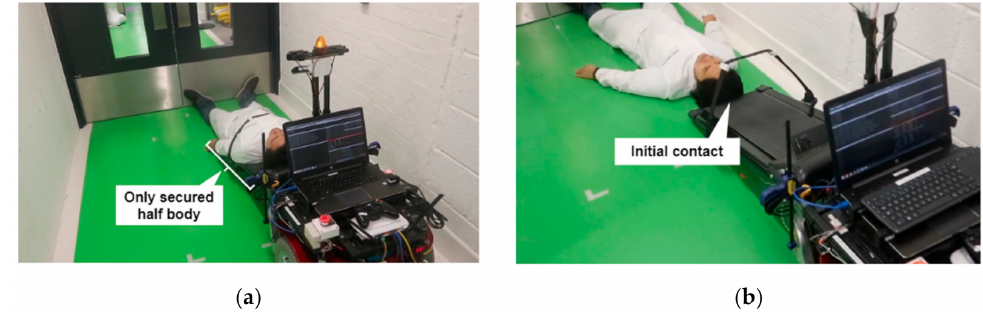
Figure 3. Two critical concerns of the ResQbot 1.0 design: ( a ) ResQbot 1.0 can only load and secure half of the casualty’s body (i.e., upper body). ( b ) The initial contact between the robot and the casualty’s head during the casualty loading process remains a critical safety concern (the potential cause of head or neck